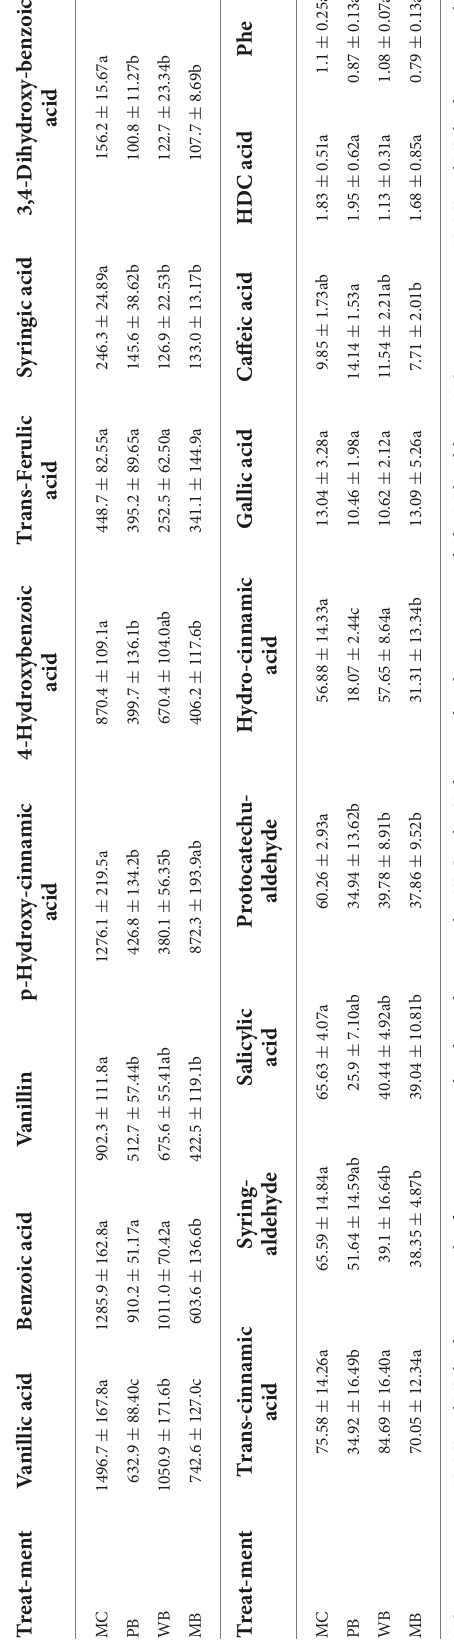
FIGURE3 Changes in total phenolics content of the rhizosphere soil sampled on the 3-year following soil amendment at 20 t ha − 1 . MC, amendment of manure compost at 20 t ha − 1 ; PB, WB, and MB, amendment of pig manure, wood, and maize biochar at 20 t ha − 1 . Different letters above the bars indicated a significant difference among treatments at p < 0.05.